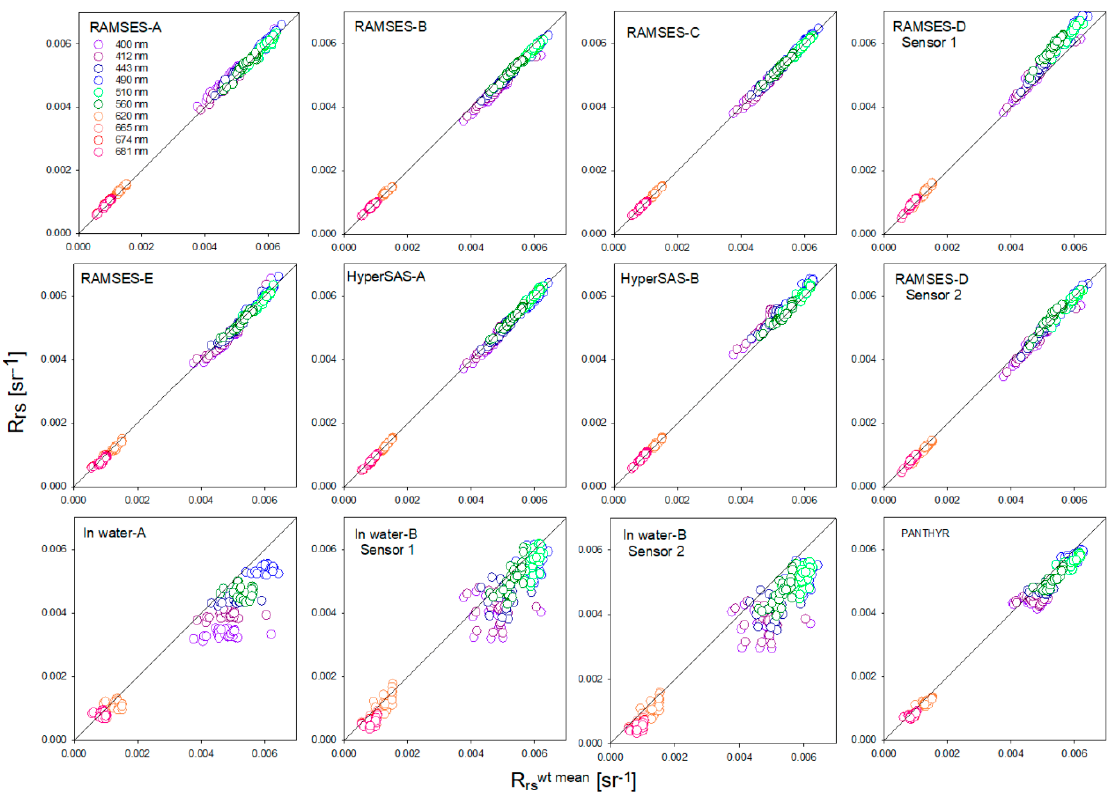
Figure 22. Scatter plots of R rs from the different above- and in-water systems versus weighted mean R rs from above-water systems (RAMSES-A, -B, -C, HyperSAS-A, -B). Reproduced with permission from [54].